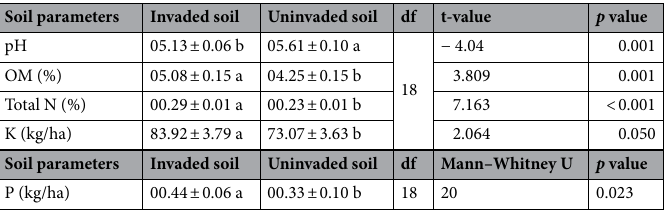
Table 2. Data on soil analysis ( A. adenophora invaded and uninvaded soils). The letters ‘a’ and ‘b’ after the mean value ± SE indicate significant differences ( p <